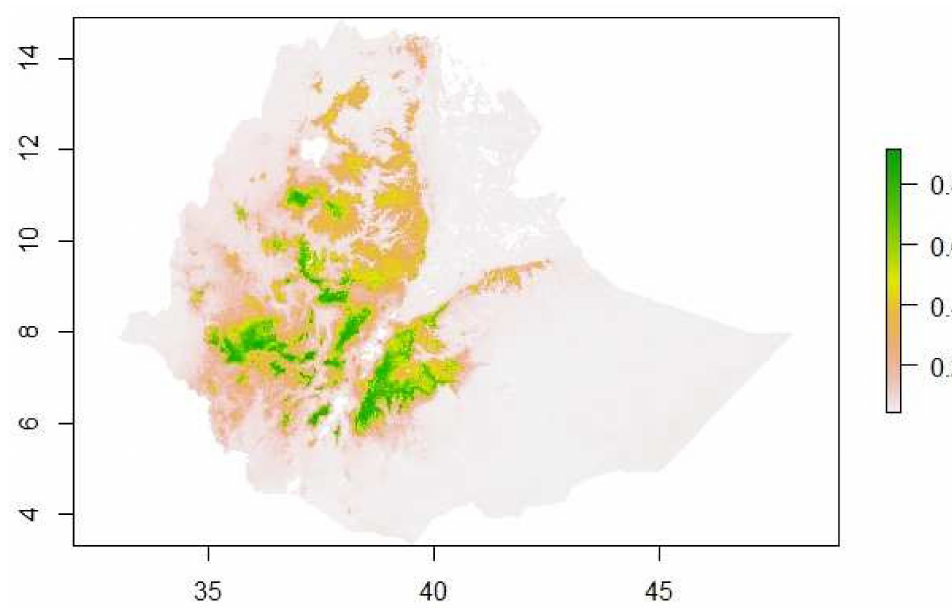
Figure 3. Predicted habitat suitability of highland bamboo in Ethiopia under current condition.